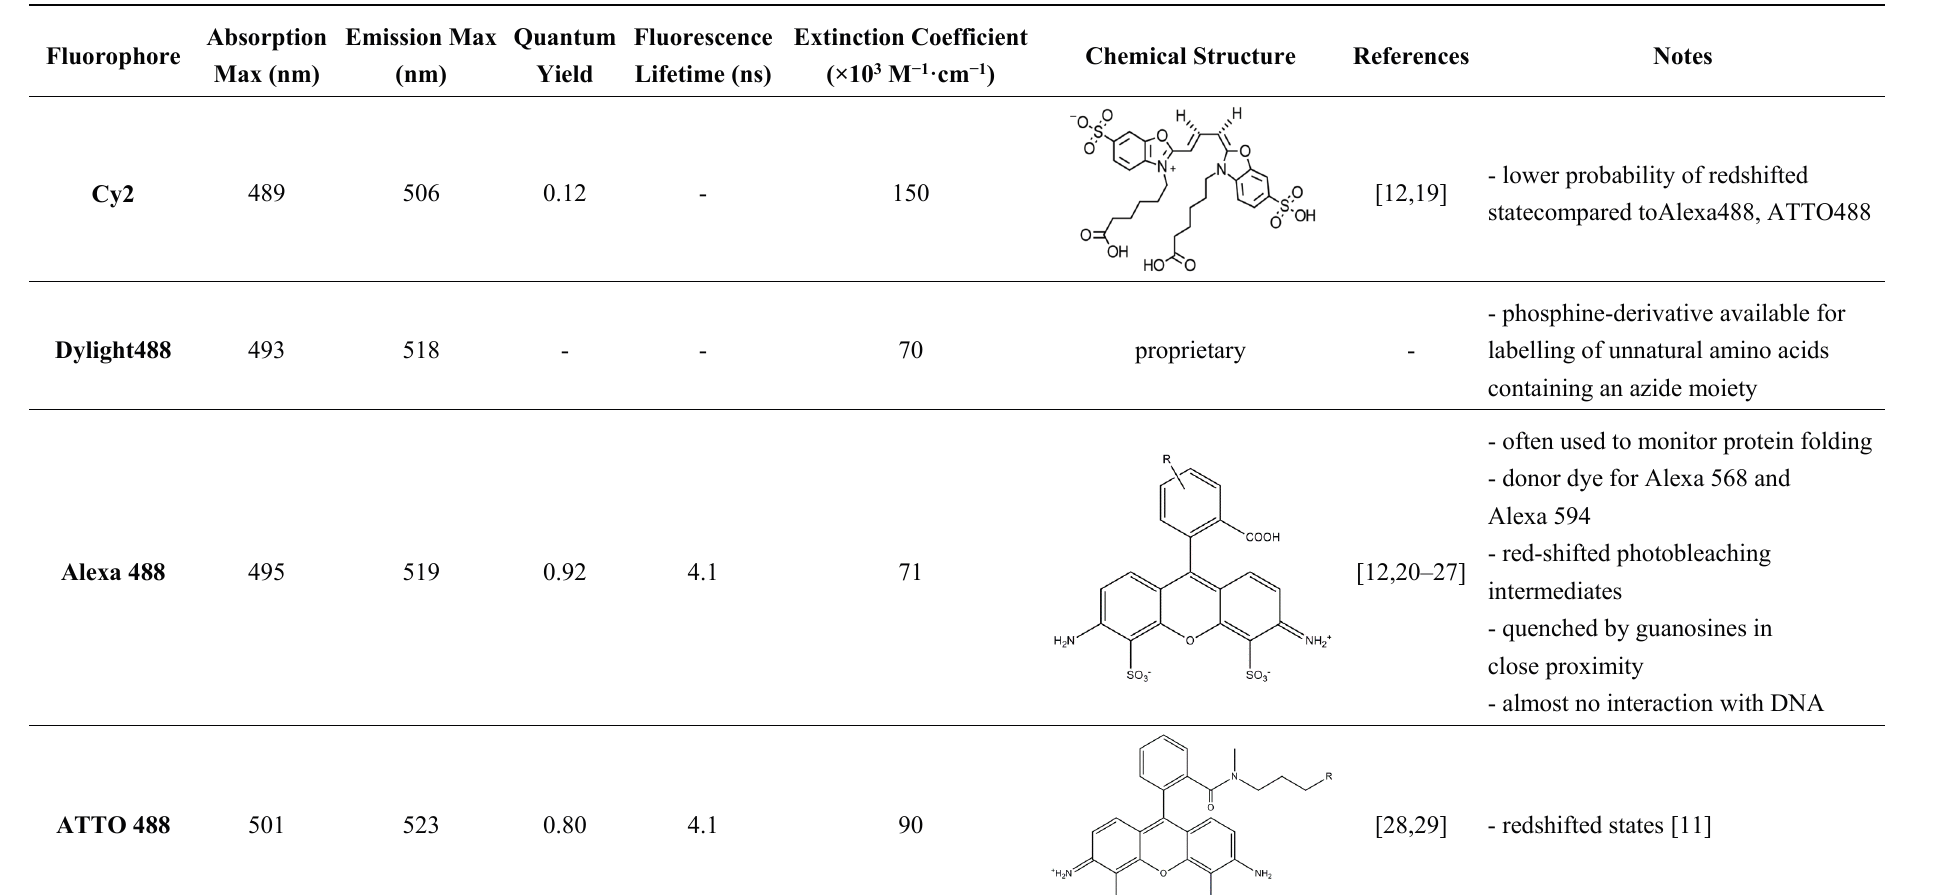
Table 1. Spectroscopic properties of commonly used organic dyes. Listed are absorption- and emission maximum, fluorescence lifetime and extinction coefficient that characterize the individual dyes ranging from blue to red. Furthermore, the chemical structure of the dye is given and the photophysical behavior is